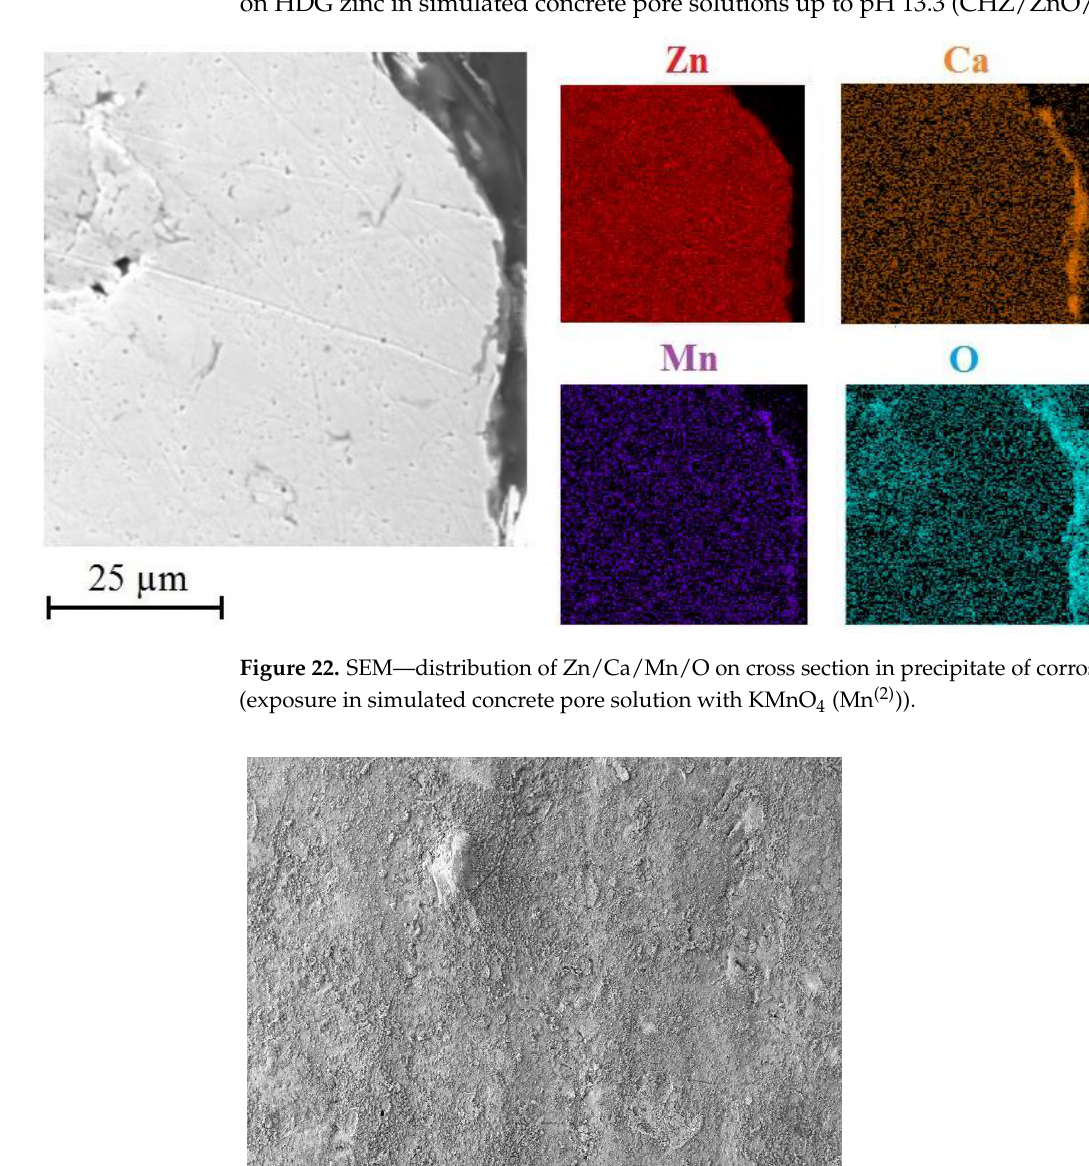
− (solution Mn (3) 4